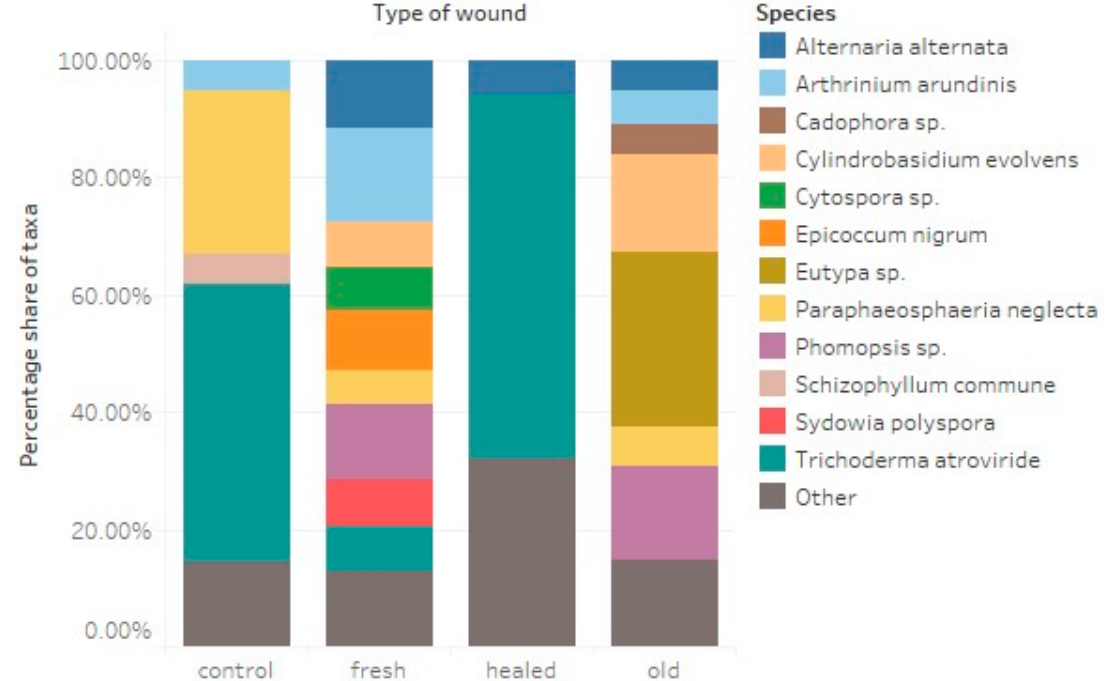
Forests 2021 , 12 , x Figure 4. Percentage share of fungal taxa inhabiting wood of three types of wounds caused by red dear on silver fir trunks and wood of control fir trees (species constituting less than 5% in total of fungal colonies were grouped to “Other”).